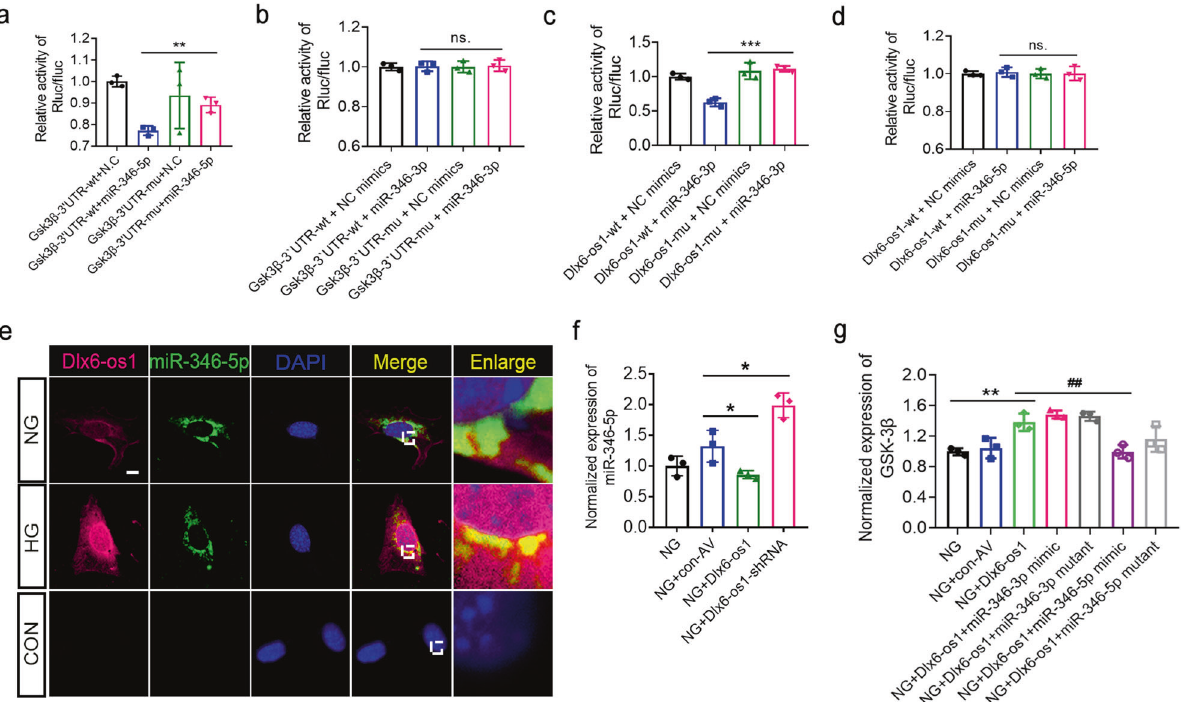
Fig. 9 The regulatory effects of lncRNA Dlx6-os1 on the expression of GSK-3 β through miR-346. a Luciferase reporter gene expression con fi rming that wild-type (WT) Gsk-3 β 3 ’ UTR can bind miR-346-5p. Mu, Mutant. ** P < 0.01, one-way ANOVA plus Tukey ’ s multiple comparisons test; n = 3. b Luciferase reporter gene expression con fi rming that wild-type (WT) Gsk-3 β 3 ’ UTR do not bind miR-346-3p. Mu Mutant, ns no signi fi cant difference. One-way ANOVA plus Tukey ’ s multiple comparisons test; n = 3. c Luciferase reporter gene testing con fi rming that the wild-type (WT) lncRNA Dlx6-os1 can directly bind miR-346-3p. Mu, Mutant. *** P < 0.001. One-way ANOVA plus Tukey ’ s multiple comparisons test; n = 3. d Luciferase reporter gene testing con fi rming that the wild-type (WT) lncRNA Dlx6-os1 cannot directly bind miR-346-5p, Mu Mutant, ns no signi fi cant difference (one-way ANOVA plus Tukey ’ s multiple comparisons test); n = 3. e FISH con fi rming the colocalization of lncRNA Dlx6-os1 and miR-346-5p in MPC5 podocytes under different glucose conditions. The lncRNA Dlx6-os1 expression level is increased, and the extent of their colocalization (yellow area) is increased in podocytes treated with high glucose (HG), while the expression of miR-346- 5p was reduced. f qRT-PCR detection of the expression levels of miR-346-5p in MPC5 podocytes after lncRNA Dlx6-os1 overexpression (NG + Dlx6-os1) or knockdown (NG + Dlx6-os1 shRNA). NG normal glucose. * P < 0.05; n = 3. g qRT- P CR detection of the expression levels of GSK-3 β in MPC5 podocytes overexpressing lncRNA Dlx6-os1 with miR-346 (5p or 3p) mimics or mutant. ** P < 0.01; ## P < 0.01 (One-way ANOVA plus Dunnett ’ s multiple comparisons test); n =